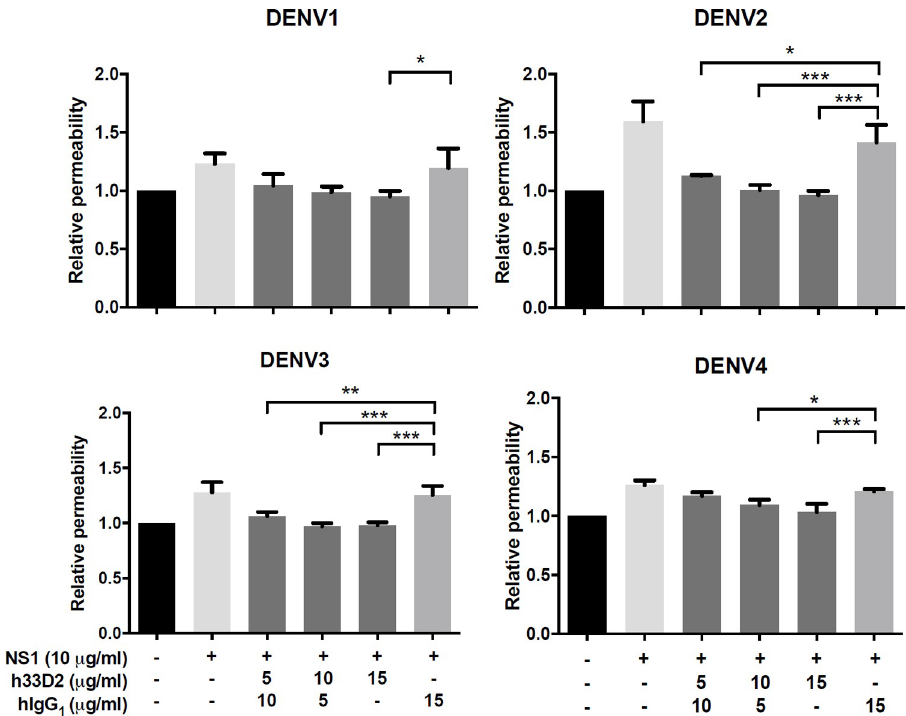
Fig 5. Humanized anti-NS1 mAb 33D2 can reduce NS1-induced endothelial permeability. Isotype control hIgG1 was combined with different doses of h33D2 at 15 μ g/ml final antibody concentration. DENV NS1 from serotypes 1, 2, 3 and 4 was used at 10 μ g/ml of final concentration. DENV1-4 NS1-induced HMEC-1 cell hyperpermeability was determined as described in the methods. All data are presented as the averages of triplicate cultures ± S.D. � : p < 0.05, �� : p < 0.01, ��� : p < 0.001, as compared with hIgG1 group and analyzed by one-way ANOVA followed by Dunnett’s multiple comparison test.